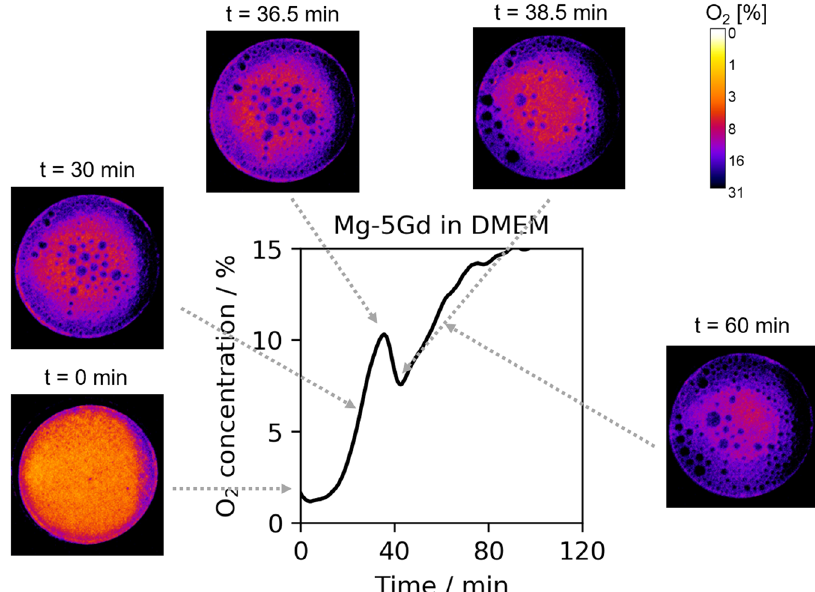
Fig. 6 Visual correlation of optical images and measured O 2 concentration dynamics. It is apparent that H 2 gas bubble formation plays a major role in inhibiting the ORR. The image contrast in the optical images was adjusted for better visibility.